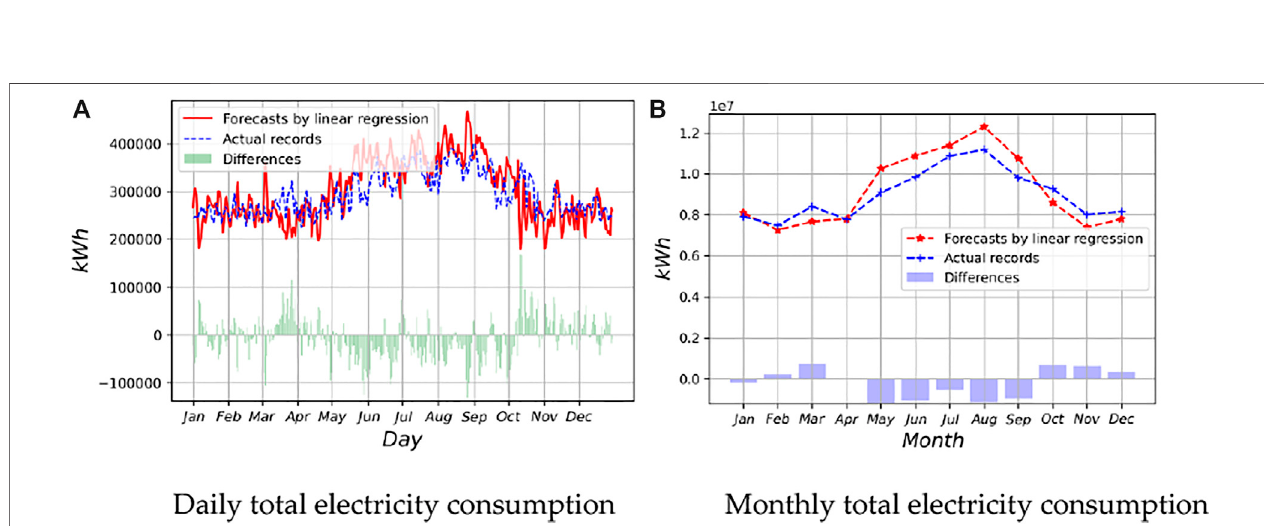
FIGURE 10 | Comparison of monthly total electricity consumption and monthly total electricity consumption with and without COVID-19. (A) Daily total electricity consumption; (B) Monthly total electricity consumption.